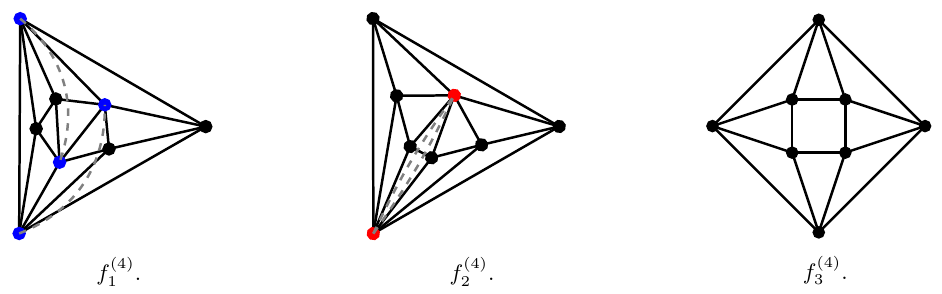
Figure 2. Here we draw f -graphs that contribute the correlator at four loops in the planar limit. They are also given in figure 8 in [17]. The solid straight lines denote propagators and the dashed lines are the numerators (or inverse propagators). The blue or red vertex means it has one or two numerator(s) attached, respectively. This ensures that each vertex has degree ( − 4) , if we count each solid straight line as ( − 1) and dashed line as (+1)